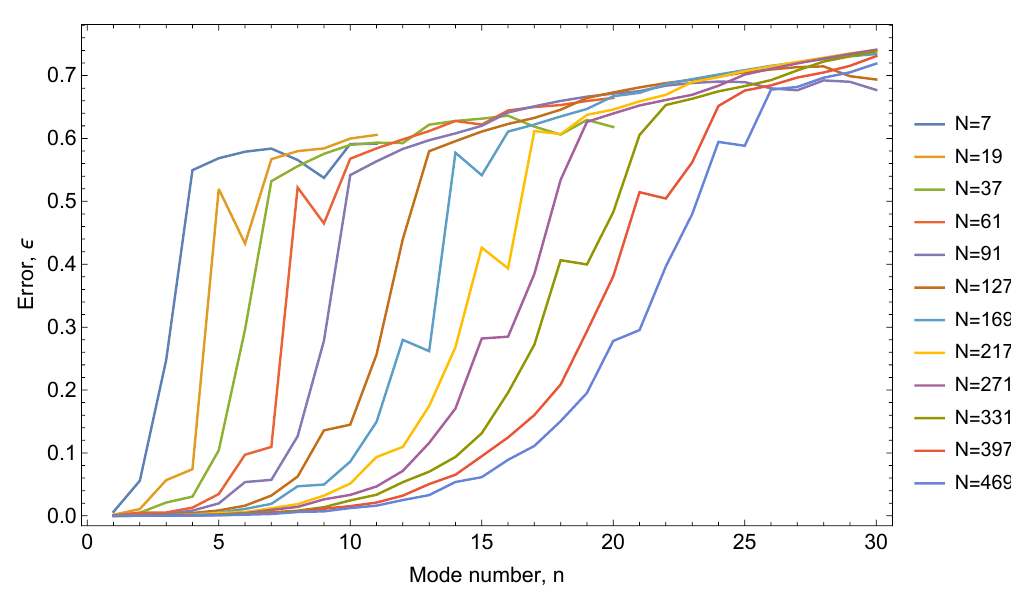
Figure 4: Error, ε , defined in (73), for fitting the anti-holomorphic mode z n , for lattices of size N . For N large there is a sustained region of low error, corresponding to realisable anti-holomorphic modes. The error grow with n and is observed to reach a threshold value before increasing linearly. The threshold is found to grow as N 1 / 2